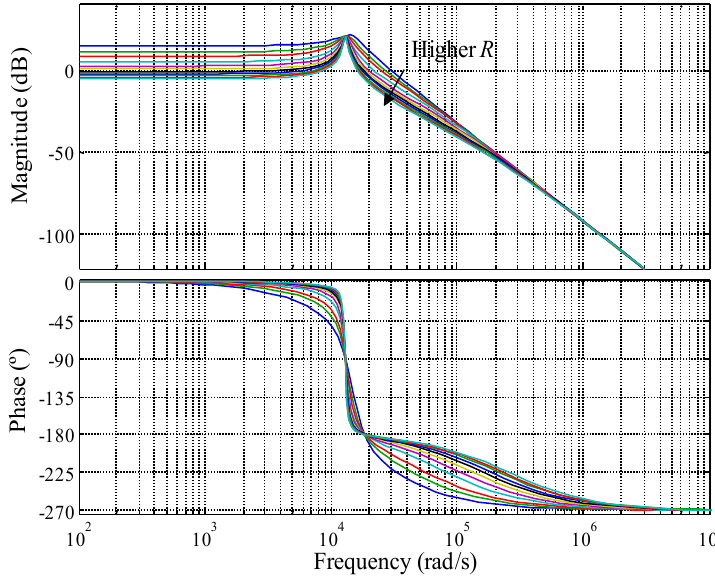
, 1.5 R , 2 R nom nom nom